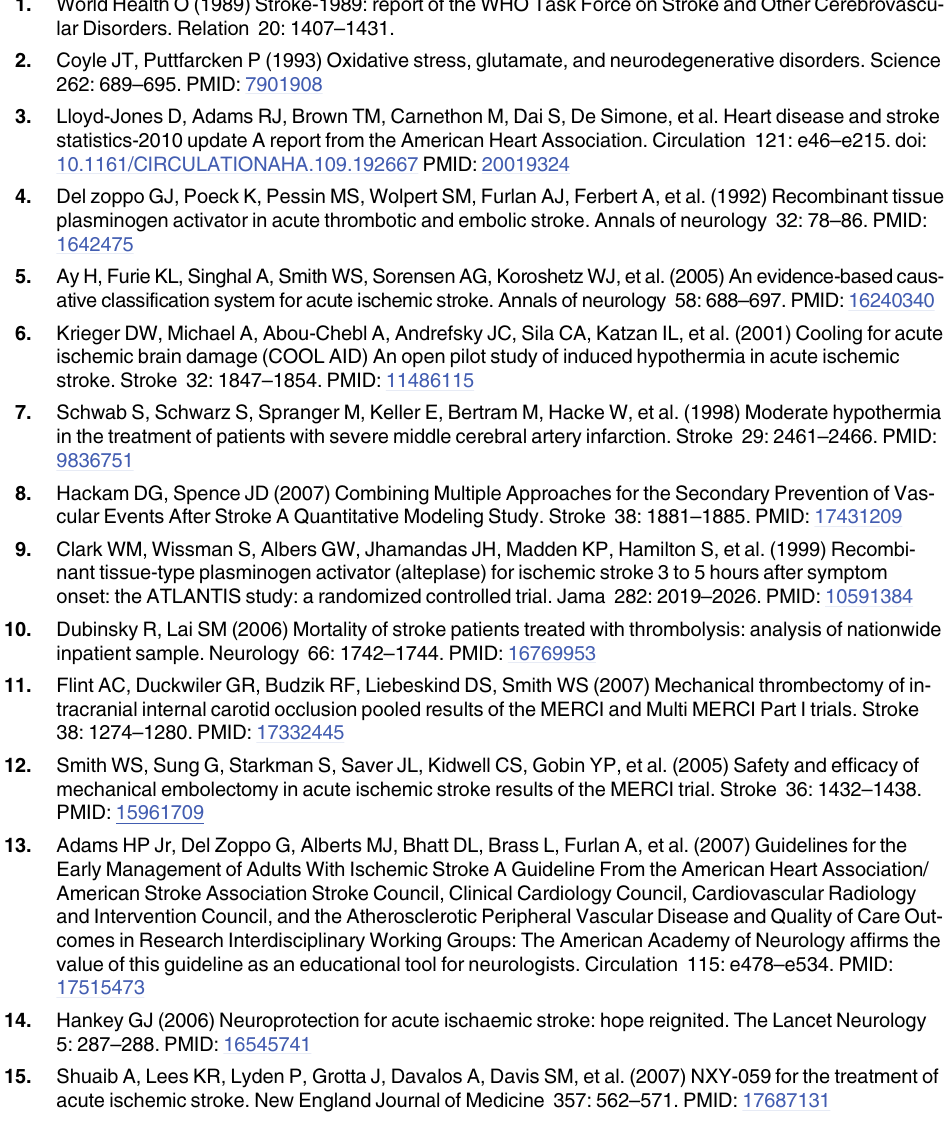
S1 Table. Genes associated with ischemic stroke from two resources. S2 Table. The score of the impact of CYNA on the pathway